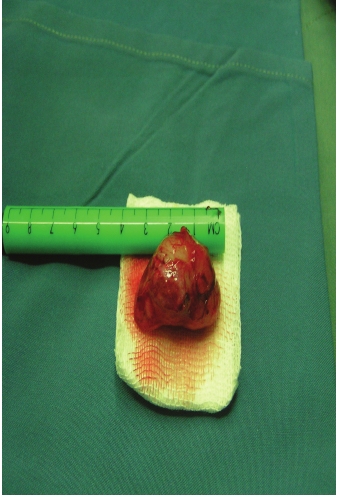
Figure 3: Gross view of excised tumor.